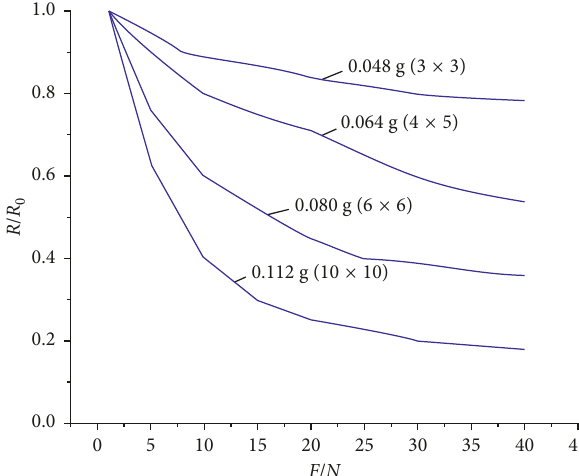
Figure 7: Relationship between quality and resistivity of carbon nanotubes. Figure 8: Pressure-resistance characteristics under different qualities of the same carbon